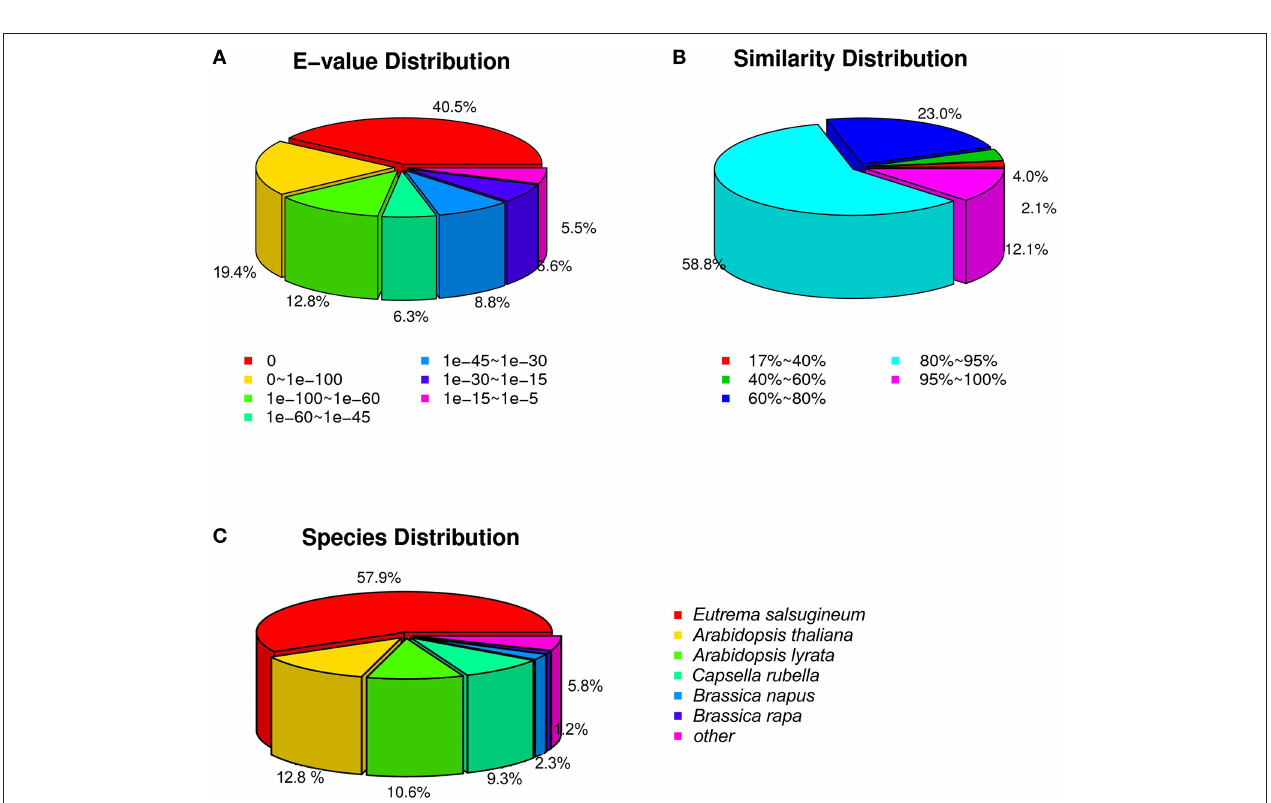
FIGURE 3 | The distribution of unigenes annotated to the NCBI non-redundant nucleotide sequence (Nt) database. (A) E -value distribution. (B) Similarity distribution. (C) Species distribution.